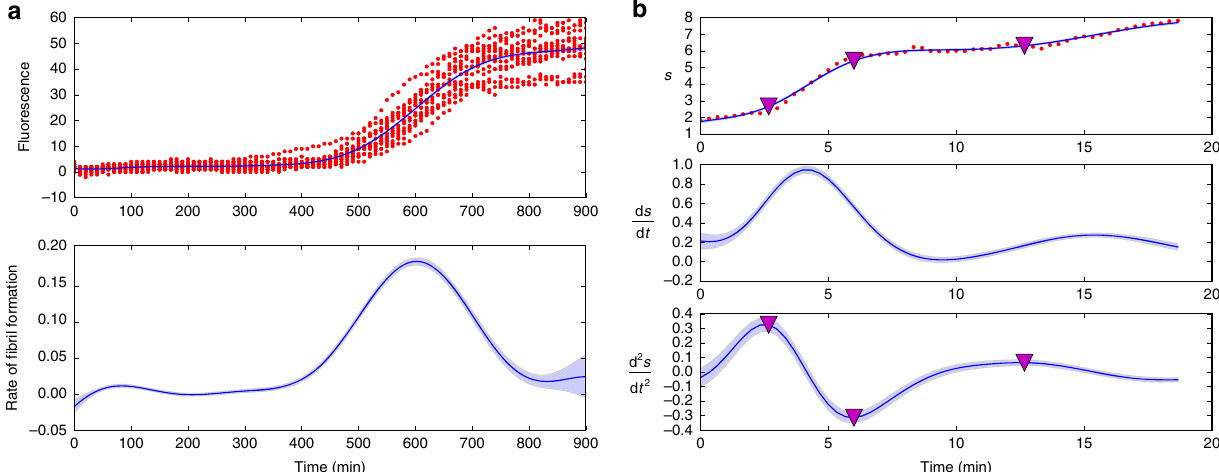
Figure 5 | The algorithm has wide application. ( a ) Inferring the in vitro rate of assembly of an amyloid fibril. Fluorescence data reporting the formation of fibrils in bovine insulin (at a concentration of 0.1mgml (cid:2) 1 ) by the binding of the dye Thioflavin T are shown (red dots) with 15 replicates (each with n ¼ 91) 15 . The best fit (top) and the inferred rate of fibril assembly (bottom) are shown in dark blue. We empirically estimate the magnitude of the measurement noise across the replicates. Errors (in light blue) are s.d. ( b ) Inferring the speed and acceleration of separation of the spindle poles in S. cerevisiae . The distance, s , between the two spindles in a single cell is plotted in microns as a function of time (red dots with n ¼ 57). The best fit and the inferred speed (middle) and acceleration (bottom) are shown in dark blue. The triangles denote turning points in the acceleration and separate anaphase into stages with fast and slow elongation separated by a pause 16 . Errors are